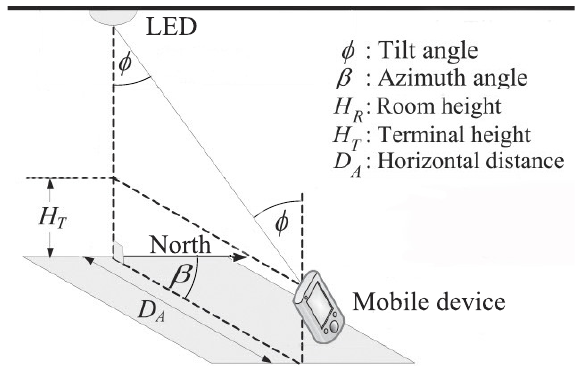
Figure 2. Positioning system using VLID and 6-axis